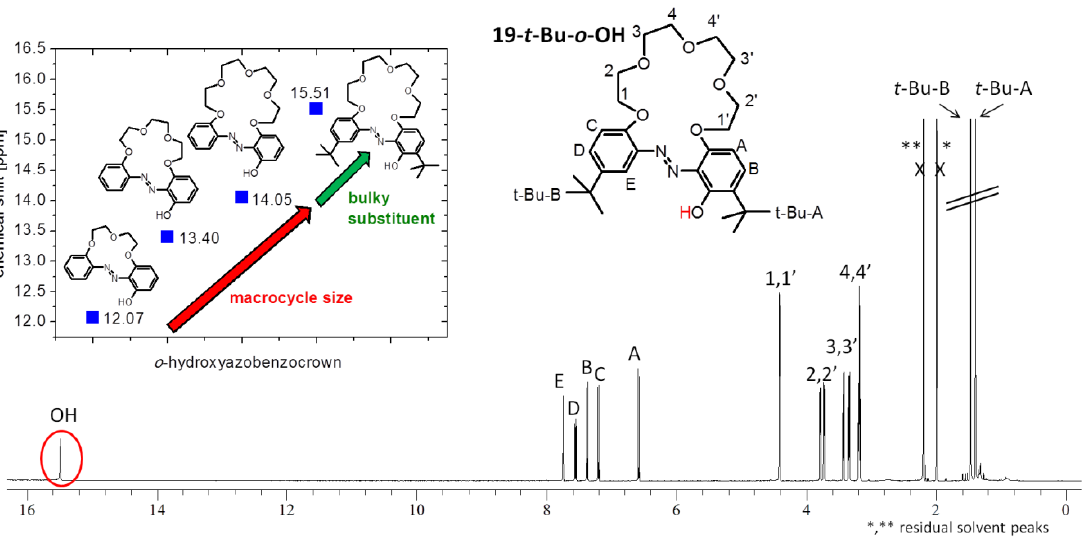
Figure 15. 1 H NMR spectrum of t -Bu-19- o -OH (6.3 × 10 − 3 M acetonitrile- d 3 ). Inset: the relationships between the values of chemical shifts of the OH proton signal in 1 H NMR spectra (acetone- d 6 ) of o -hydroxyazobenzocrowns of different macrocycle sizes.